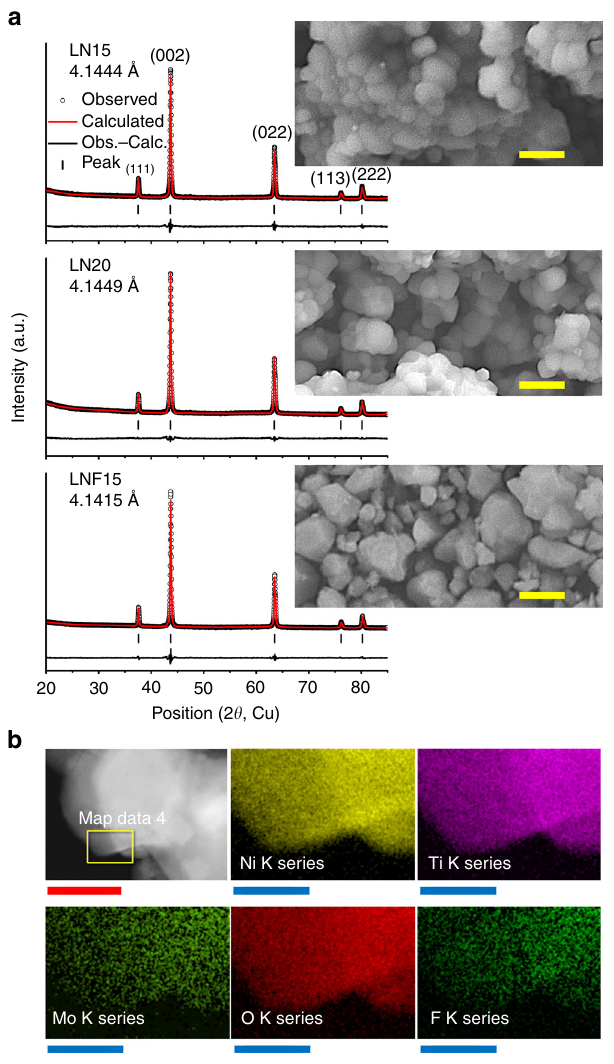
Fig. 2 Structure characterization of Li 1.15 Ni 0.375 Ti 0.375 Mo 0.1 O 2 (LN15), Li 1.2 Ni 0.333 Ti 0.333 Mo 0.133 O 2 (LN20), and Li 1.15 Ni 0.45 Ti 0.3 Mo 0.1 O 1.85 F 0.15 (LNF15). a X-ray diffraction patterns and re fi nement results of LN15, LN20, and LNF15. The inset shows the scanning electron microscopy image of each material. Scale bars, 200 nm. b Energy dispersive spectroscopy mapping (Ni, Ti, Mo, O, F) on one area (yellow square) of a LNF15 particle. Scale bars, red: 100 nm, blue: 25 nm